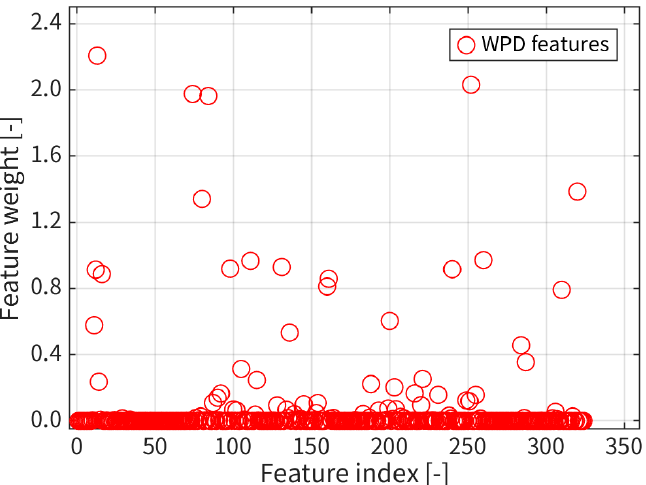
Figure 12. Feature weights of 325 features. Table 8. The 37 significant features.